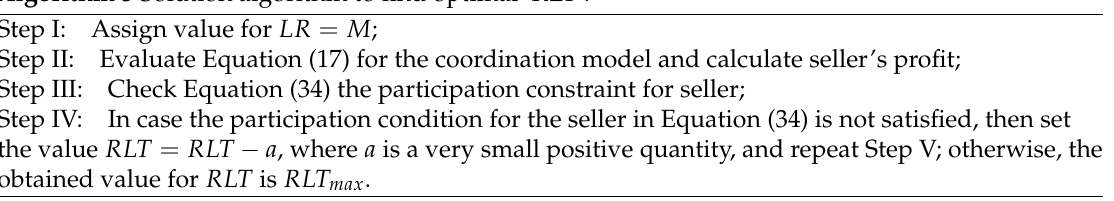
Algorithm 3 Solution algorithm to find optimal